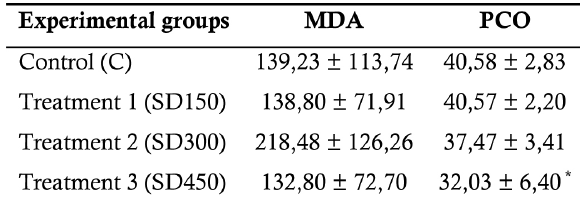
Effectiveness of Brown Algae Extract to Reduce Serum Malondialdehyde and Protein Carbonyl Levels ... Serum MDA and PCO levels after 30 days treatment with brown algae S.duplicatum extract (mean ± SD)